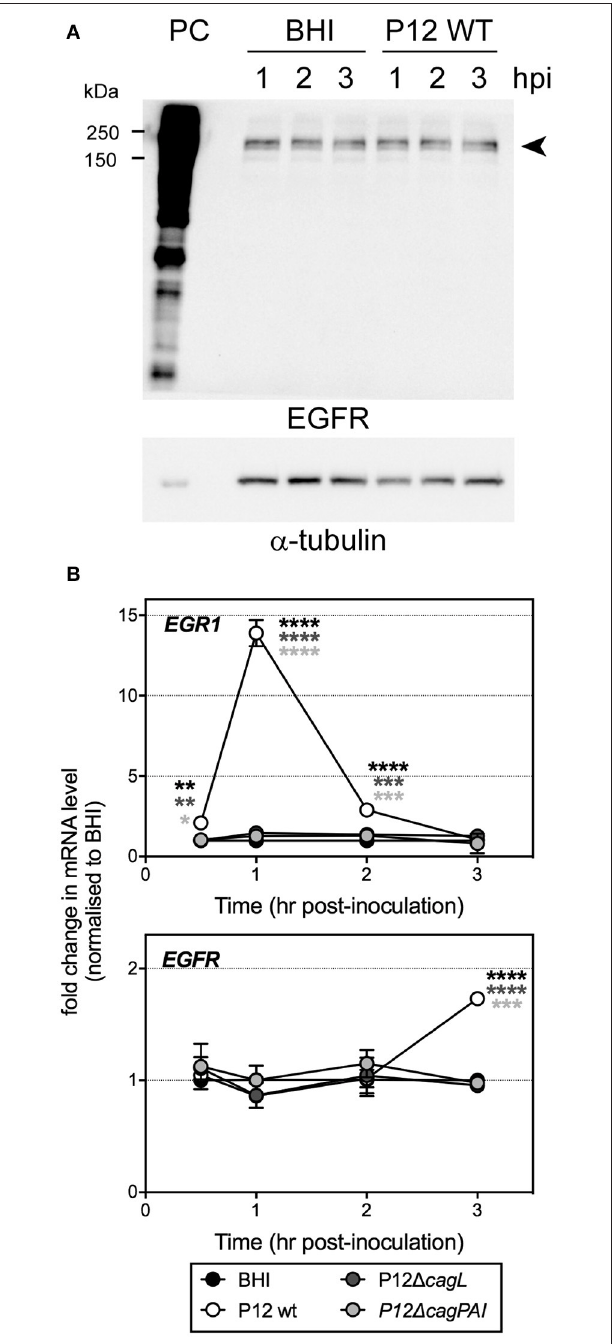
FIGURE 6 | EGFR expression in HUVECs and upregulation of EGR1 mRNA level upon infection of HUVECs with H. pylori P12. (A) HUVECs were inoculated with BHI broth or H. pylori P12 WT (MOI = 50). Cell lysates (30 µ g) were harvested at 1, 2, and 3h post-inoculation for quantitation of EGFR protein level by Western blot. Whole cell lysate (20 µ g) of the basal MDA-MB 468 triple negative breast cancer cell line that abundantly expresses EGFR was used as a positive control (PC) for EGFR expression and detection. α -tubulin was used as loading control. Arrowhead indicates EGFR bands. In line with previous reports, two EGFR bands were detected, which most